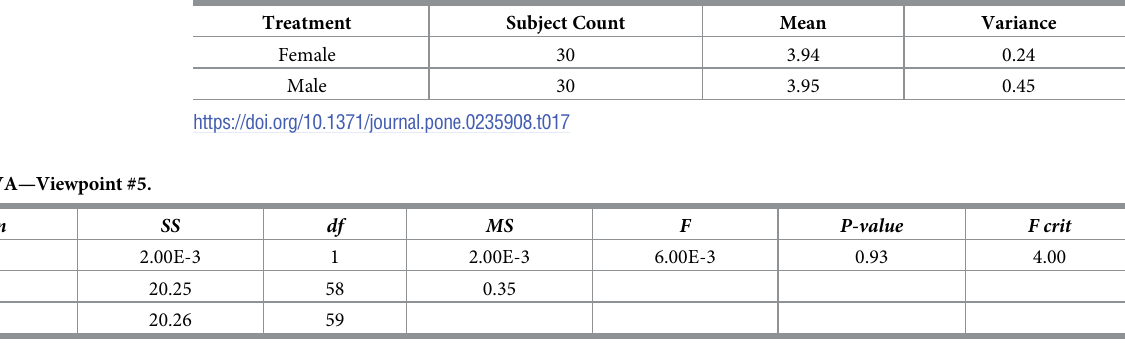
Table 17. Data summary—Viewpoint #5.